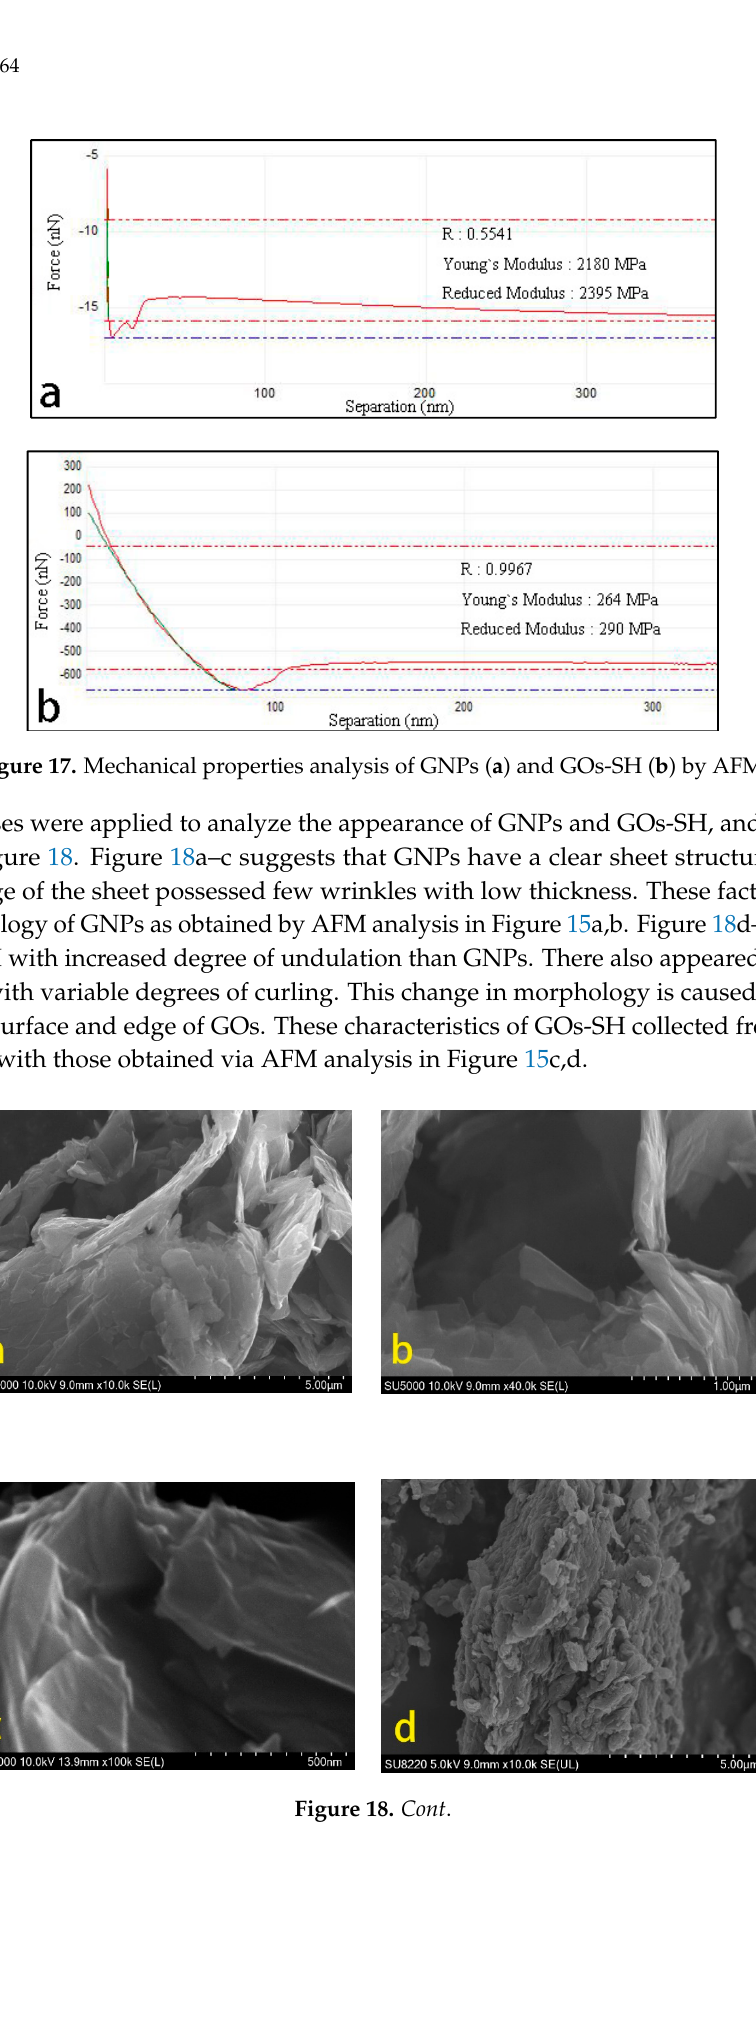
Figure 18. SEM analysis of GNPs ( a – c ) and GOs-SH ( d – f ).